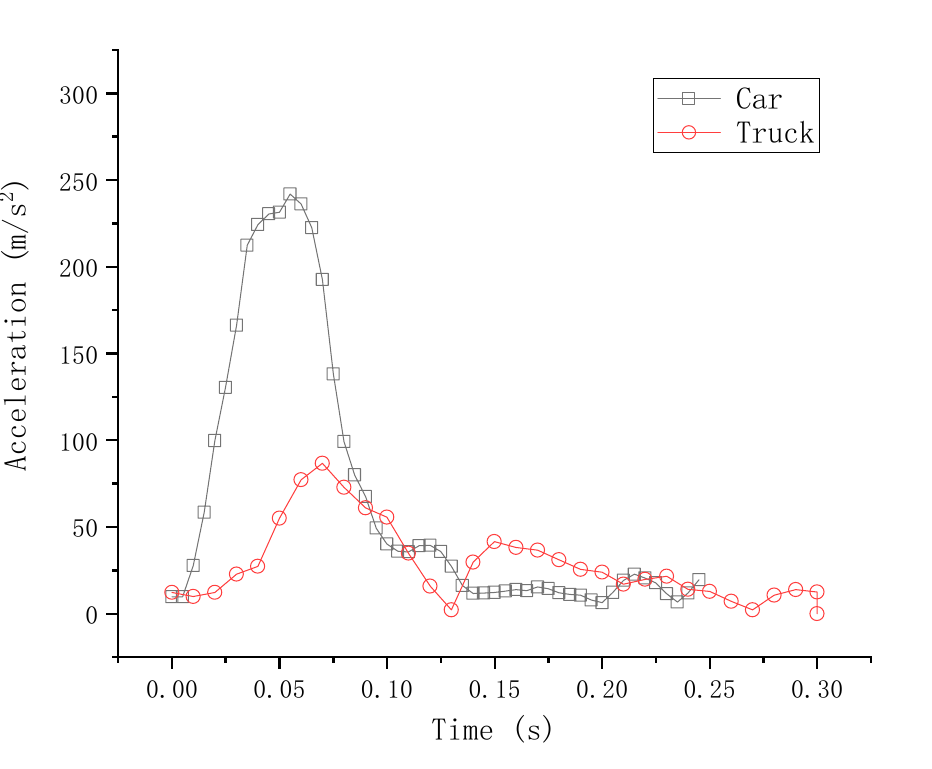
Figure 15. Acceleration–time curve of cars and trucks.